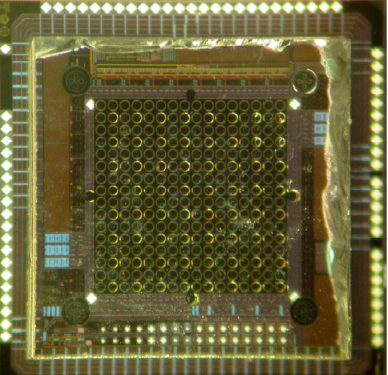
Figure 3. AlInGaN micro-LED array bump-bonded to an 8 × 8 CMOS driver array.